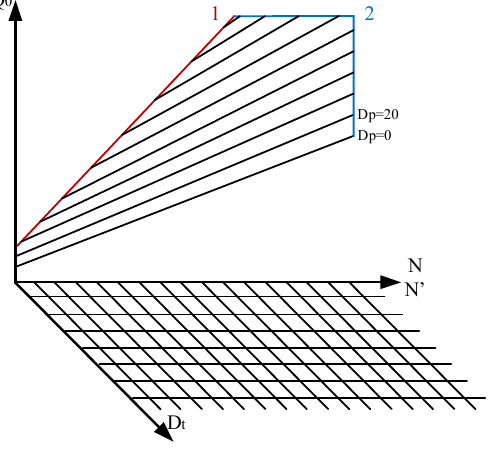
Fig. 2. A simplified form of the typical